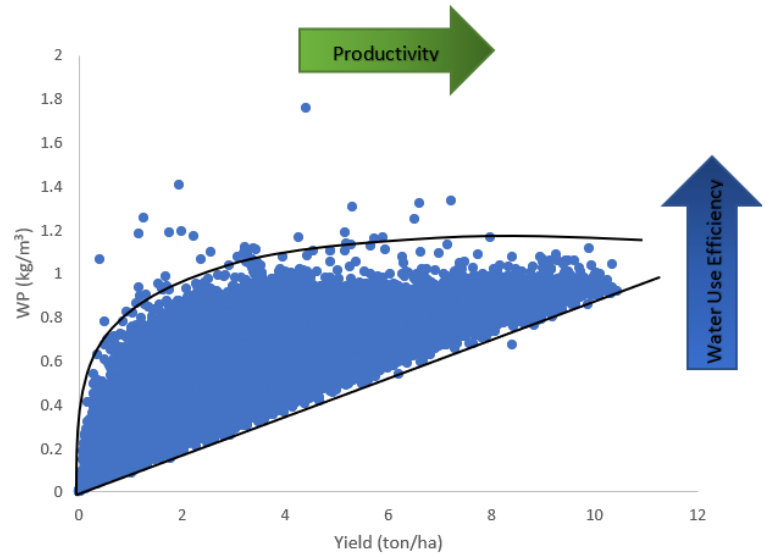
Figure 10. WP – Yield relationship for wheat in the study area. Figure 10. WP–Yield relationship for wheat in the study